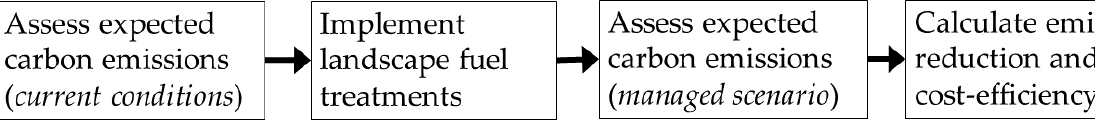
Figure A3. Dry weight (T ha − 1 ) of dead fuel categories, including litter, duff, 1 h, 10 h, 100 h, and 1000 h, fuel load components on the dominant forest types within the LUs. See dominant tree species abbreviations in Table 1. Regular stand ages included low pole-stage (LP), high pole-stage (HP), and timber stage (T).